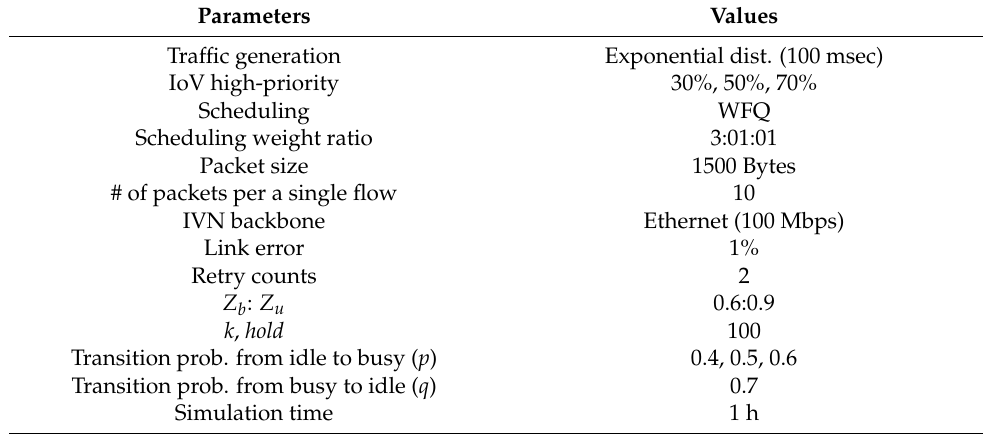
Table 1. Simulation parameters.